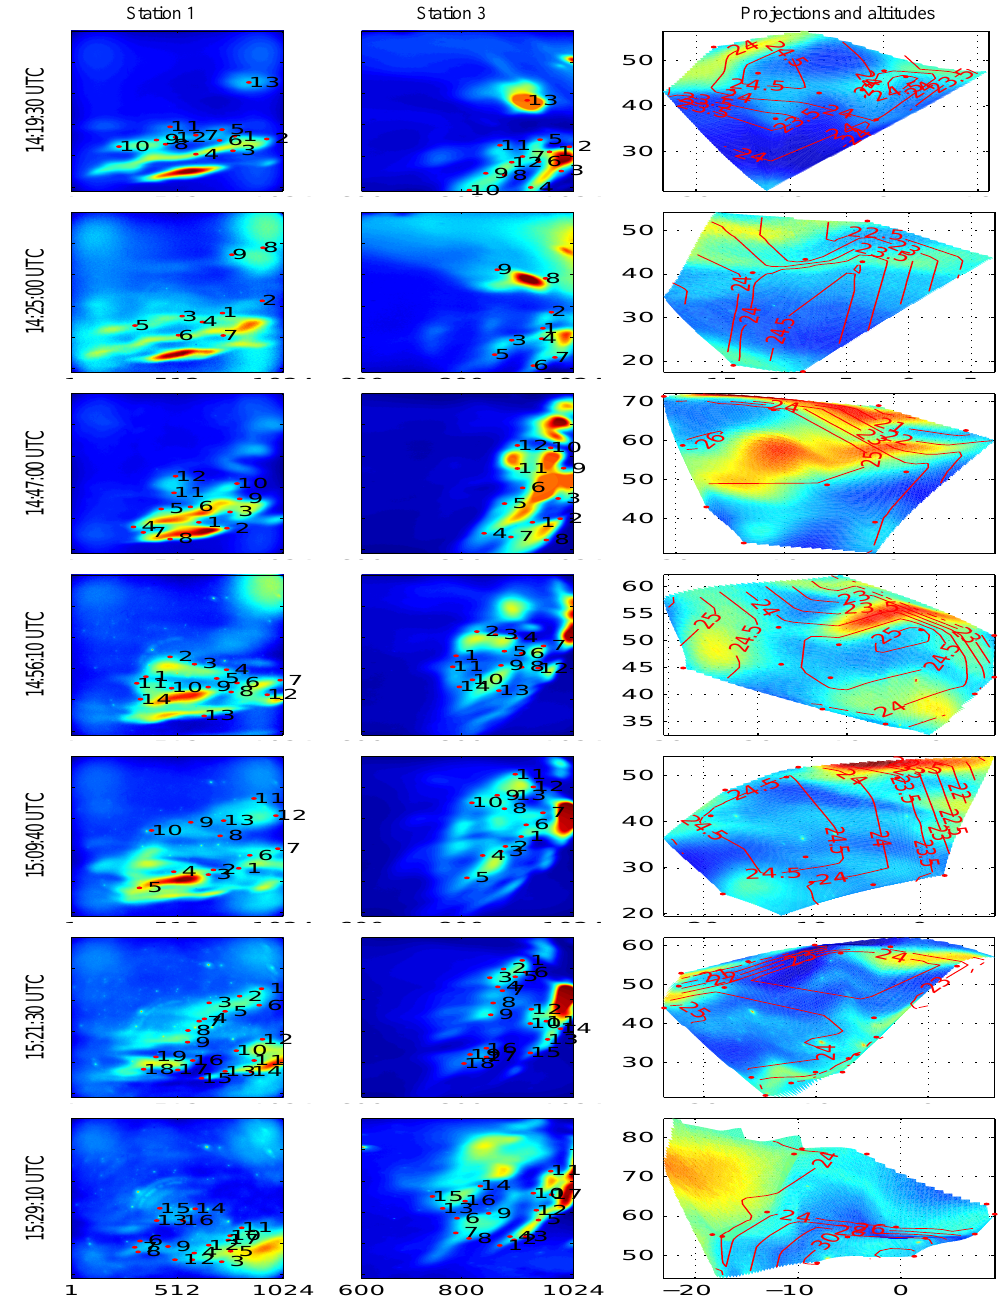
Fig. 14. Columns 1 and 2: Time series of images with identified PSC points (colour bars show the pixel values in 10 4 A/D counts after background subtraction). Rows 1-1024 and columns according to the abscissae are shown. Column 3: Contour surfaces (km) spanned by these points, superimposed on projections of the images from station 1. The axes show W-E and N-S distances in kilometres from Kiruna.